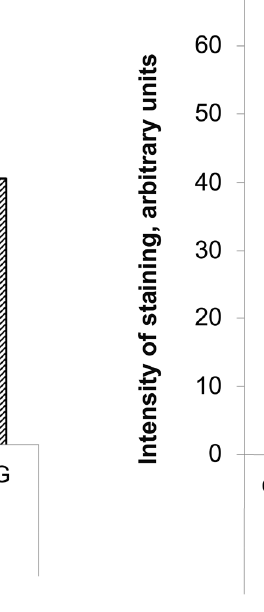
Figure 6. Intensity of immunostaining for ABA ( A ) and IAA ( B ) of root primordia of Az34 and Steptoe plants grown under normal or stress conditions (6% polyethylene glycol (PEG)). Images were taken from the sections presented in Figures 2, 3, 5 and 6. Means (arbitrary units, maximal staining taken as 100%, minimal—as 0%). Significant differences are marked with different letters. Values are means ± S.E. ( n = 25) ( p ≤ 0.05, t-test) .